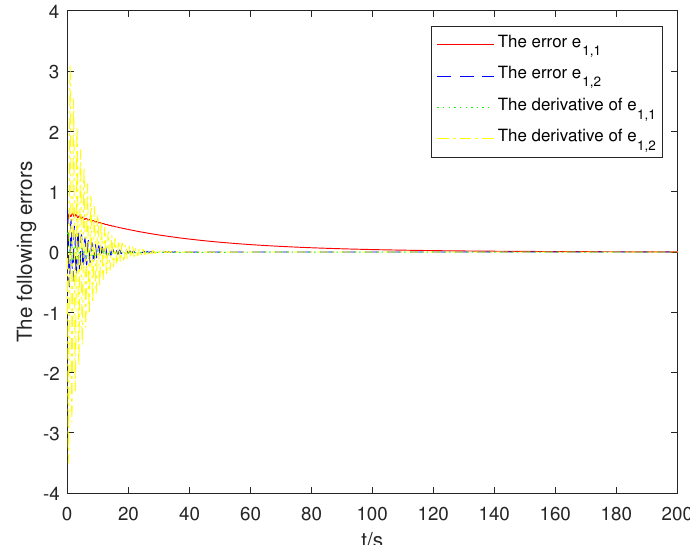
Figure 2. Curves of the following errors e ( t ) under actuator